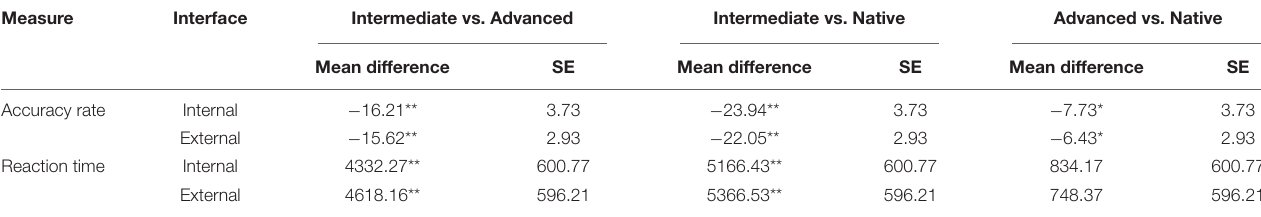
TABLE 3 | Pairwise comparison results for the two-way interactions. Measure Interface